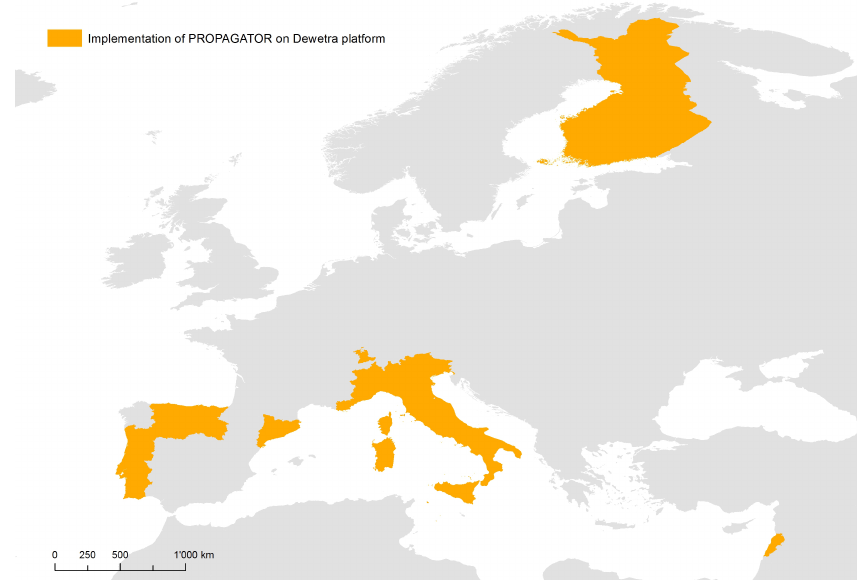
Figure 2. All the regions were PROPAGATOR simulations can be run using a Dewetra